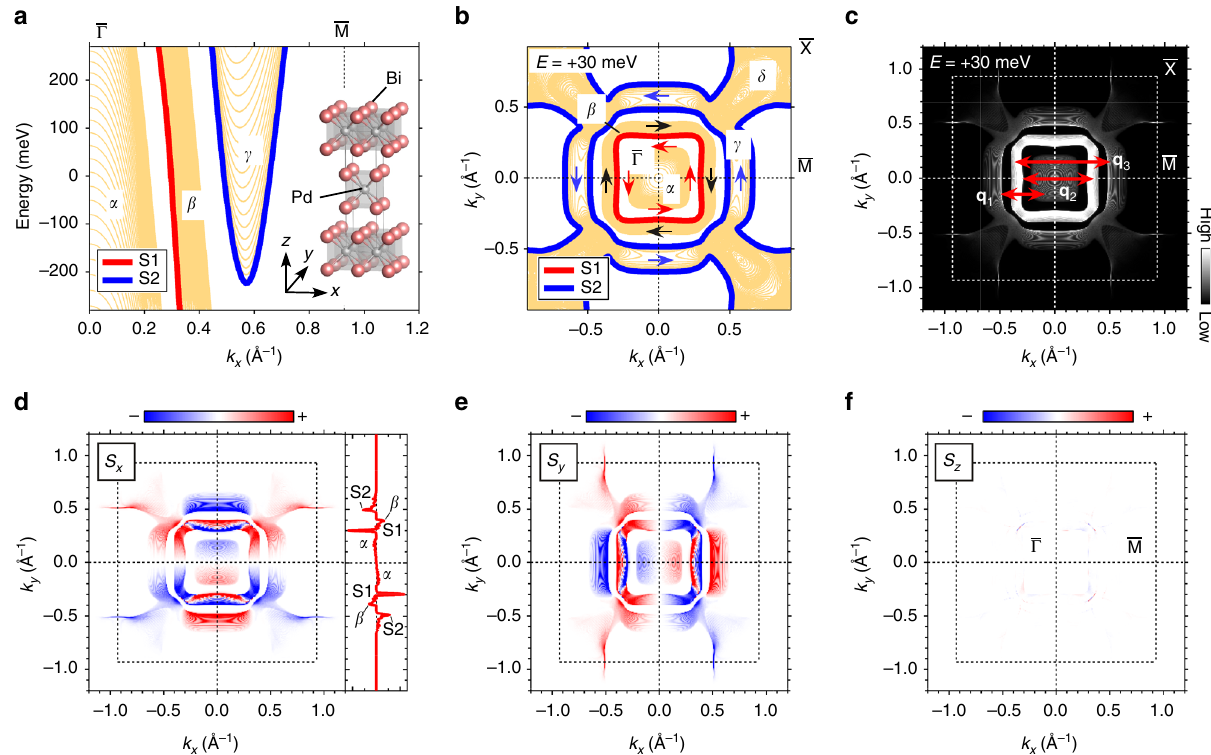
Fig. 1 Calculated surface electronic states of the top-most Bi layer of β -PdBi 2 . a Energy dispersions of the surface (topologically trivial S1 and nontrivial S2) and the bulk states ( α , β and γ ) along the Γ − M direction. The inset shows the crystal structure of β -PdBi 2 . b The constant energy contours (CECs) at energy E = +30 meV. The CECs consist of the two surface states (S1 and S2) and the bulk states ( α , β , γ and δ ). The spin orientations of S1 (red), S2 (blue) and β (black) are schematically shown by arrows. c Spectral function at E = +30 meV with the Wannier transformation written in Methods section. The inter- band forward-scattering from α to Γ -centred S2, the inter-band back-scattering from S1 to β , and from Γ -centred S2 to β along the Γ − M direction is indicated as q 1 , q 2 and q 3 , respectively. A dashed square denotes the fi rst Brillouin zone. d – f Spin polarisations weighted by the spectral function at E = +30 meV are shown for all components, s x , s y and s z . A line pro fi le of s x along M − Γ − M is shown in d where S1, S2, α and β are clearly identi fi ed. The spin orientations of S1, S2 and α are anticlockwise whereas the spin orientation of the β band is